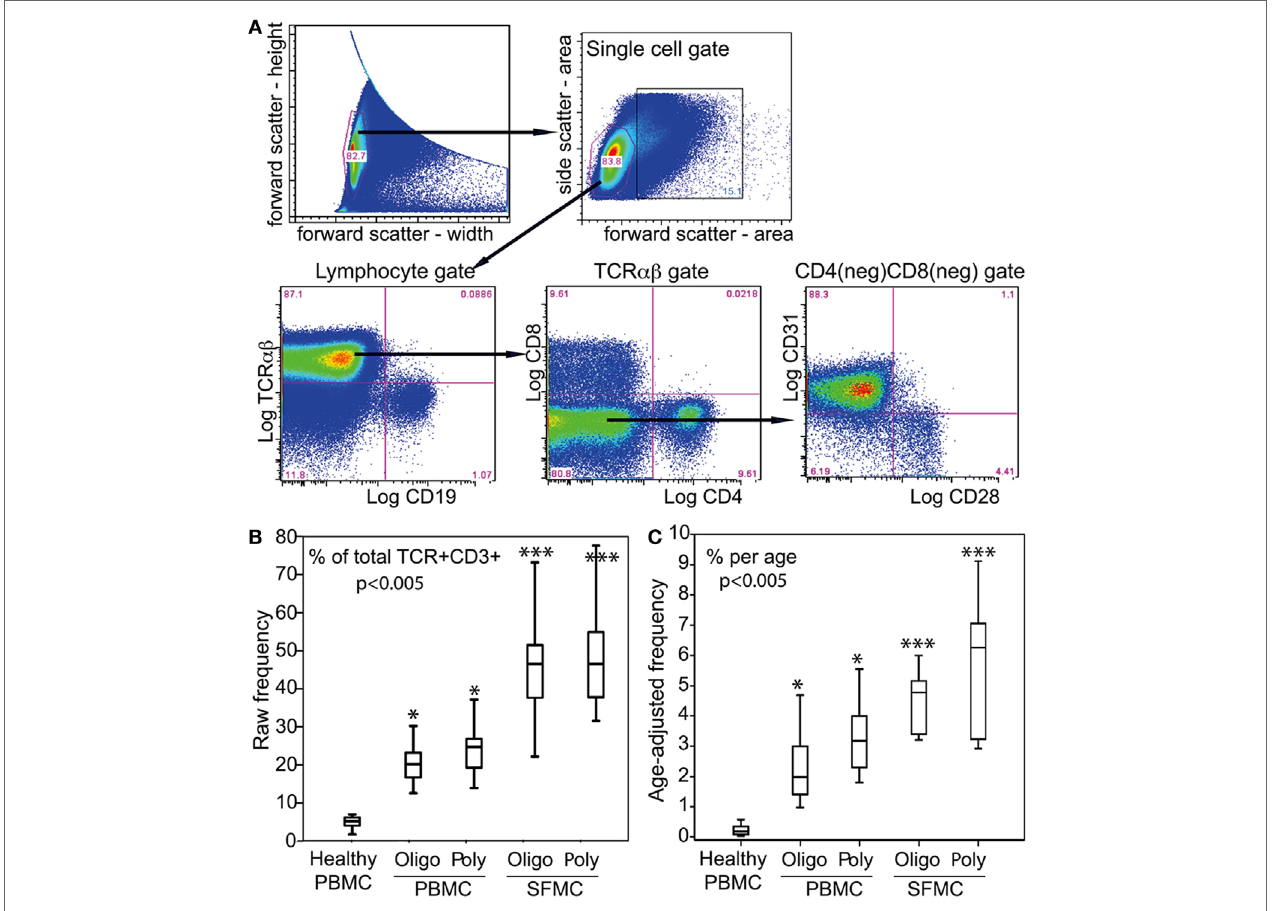
FigUre 2 | αβ T cell profiles in PBMC and SFMC of JIA patients. (a) Illustrative flow of the electronic gating strategy for cytometric determination of the expression of TCR αβ , CD4, CD8, CD28, and CD31. The gating profile shown was for an SFMC sample, which was very similar with a parallel PBMC gating profile. Following an initial live/dead electronic gate, the height and width of the forward scatter was used to set a single cell gate for lymphocytes that were sequentially examined for CD4, CD8, CD28, and CD31. (B) Box-median-whisker plots shown are the raw frequency and (c) the age-adjusted frequency of CD31 + CD28 null DN αβ T cells as a proportion of the total parent population of gated αβ TCR + cells. The plots were constructed as in Figure 1 . The indicated P -values were determined by Kruskal– Wallis analysis of variance. Post hoc group comparisons by Tukey: *** P < 0.005 indicates SFMC of oligoarticular [oligo] and polyarticular [poly] JIA were significantly different from JIA/healthy PBMC; * P < 0.05 indicates JIA PBMC was significantly different from healthy